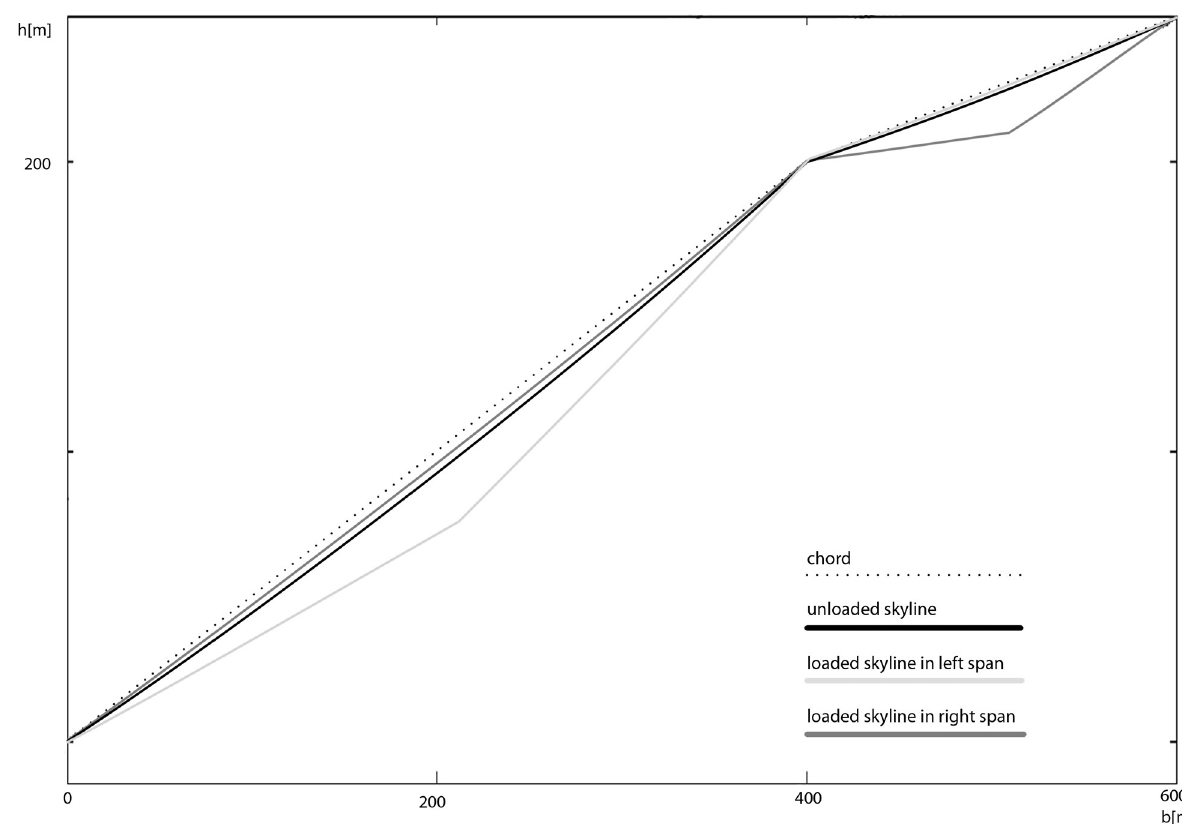
Fig 7. Cable layout with a double-span